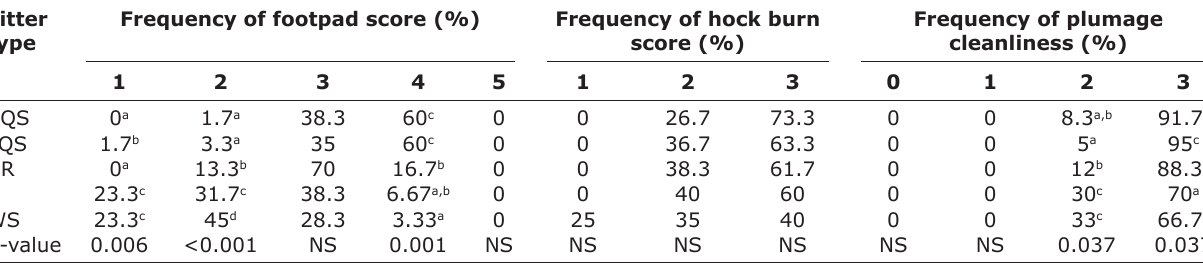
Table-2: Scoring percentages of footpad lesions, hock burn, and plumage cleanliness in broilers at 42 days of age. Litter type